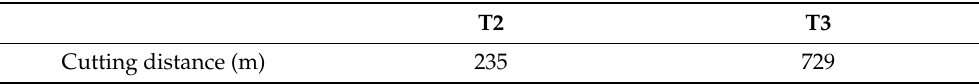
Table 4. Total cutting distance for the wear of the cutting tools (Sobelcomp).